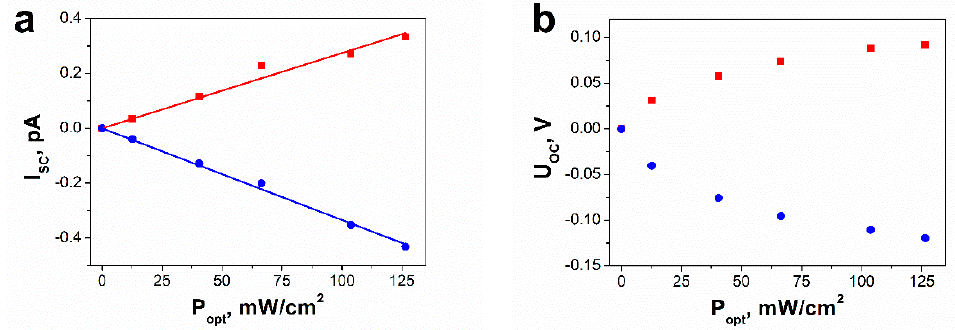
Figure 7. Influence of the optical power density on ( a ) short-circuit photocurrent and ( b ) open-circuit photovoltage of the SbSI FE-PV device with different poling electric fields: ( ■ ) E = − 10 6 V/m, ( ● ) E = +10 6 V/m ( λ = 488 nm; T = 268 K; p = 2 · 10 − 3 Pa; solid curves represent the best fitted dependences described by Equation (6); values of the fitted parameters are given in the text).